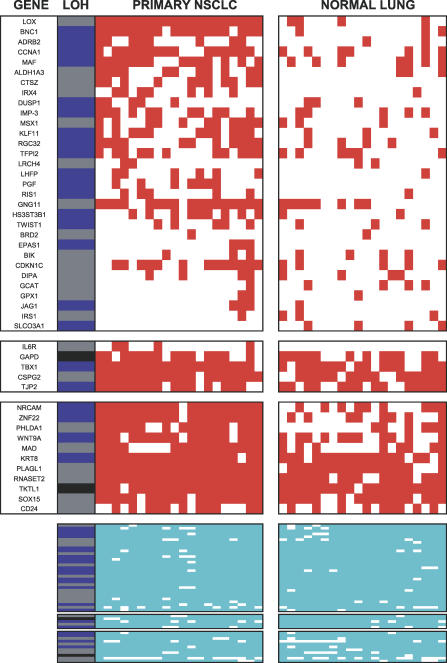
Summary of Methylation-Specific PCR in Matched Primary NSCLC and Adjacent Nonmalignant TissueData are color-coded and grouped as follows: red fill indicates positive methylated product; blue indicates positive unmethylated product. Data are grouped as follows: group I, no methylation in either HBECs or PBC DNA; group II, methylation in HBECs but not PBCs; group III, methylation in PBCs. Data are ordered from top to bottom according to the frequency of methylation in primary NSCLC. “GENE” indicates gene symbol; blue bars indicate loss of heterozygosity (LOH; allele loss) (a net [median] copy number change over 31 cell lines was calculated by taking the median signal over all cell lines); grey, no data; black, control primer sequences. Data are presented in the same order in the top (methylated) and bottom (unmethylated) panel.